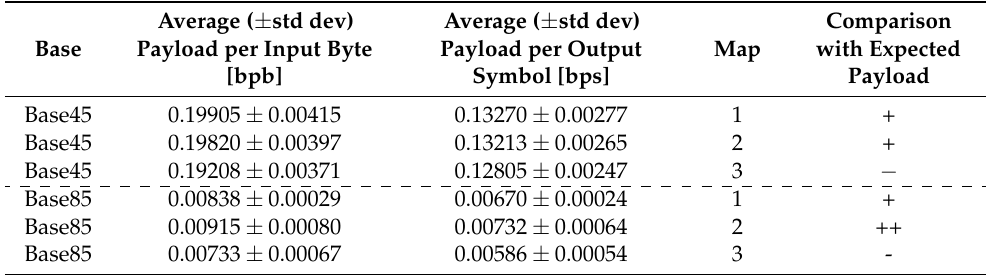
Table 2. Results of the Base45 and Base85 encodings applied to 500 JPEG colour images (average image size 109